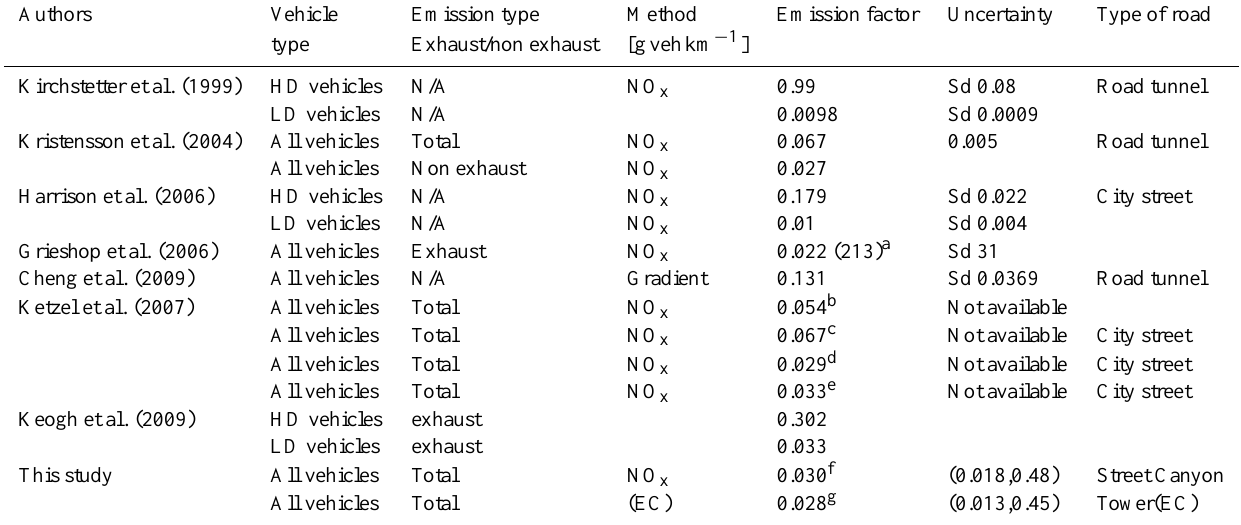
Table 2. Published emission factors for particulate mass fractions on road studies.